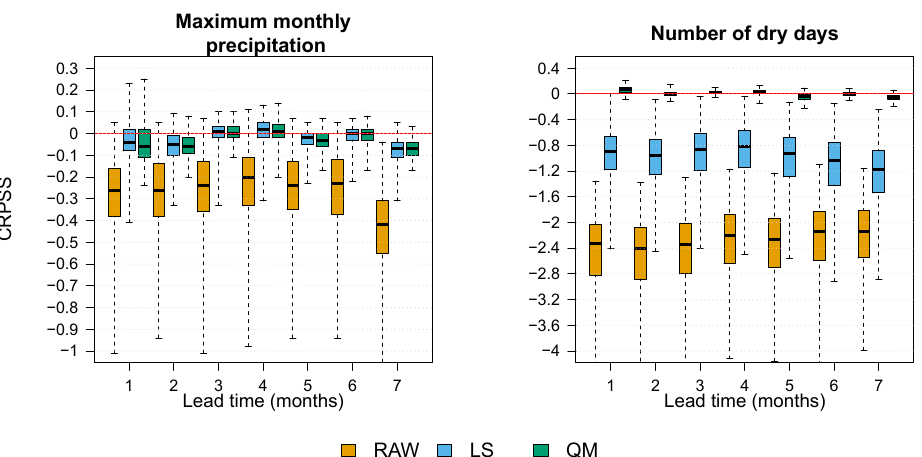
Figure 12. Skill of daily monthly maximum P and number of dry days for target month January for all 7-month lead times for the raw and post-processed forecasts. Box plots represent the values of CRPSS, of Eq. (8) with climatology as reference, of all the 662 or 724 grid points covering